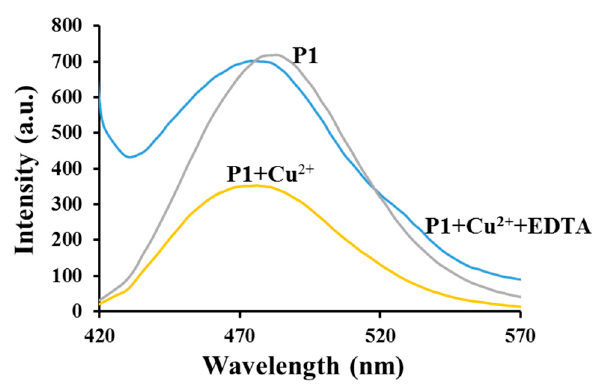
Figure 10. Reversibility of the interaction between P1 and Cu 2+ upon EDTA addition.